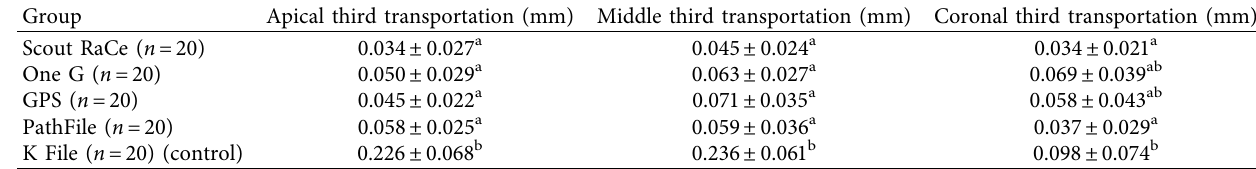
Table 2: Mean transportation values at apical, middle, and coronal canal thirds for each experimental group.